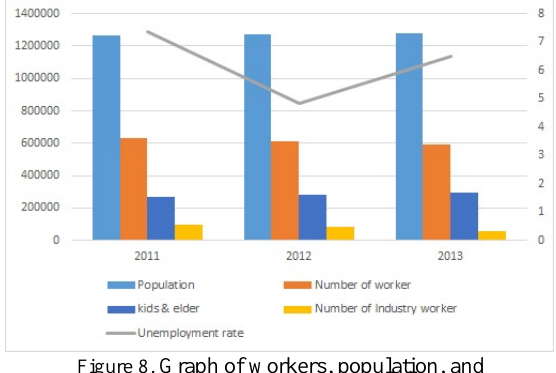
Figure 8. Graph of workers, population, and unemployment rate in Pemalang